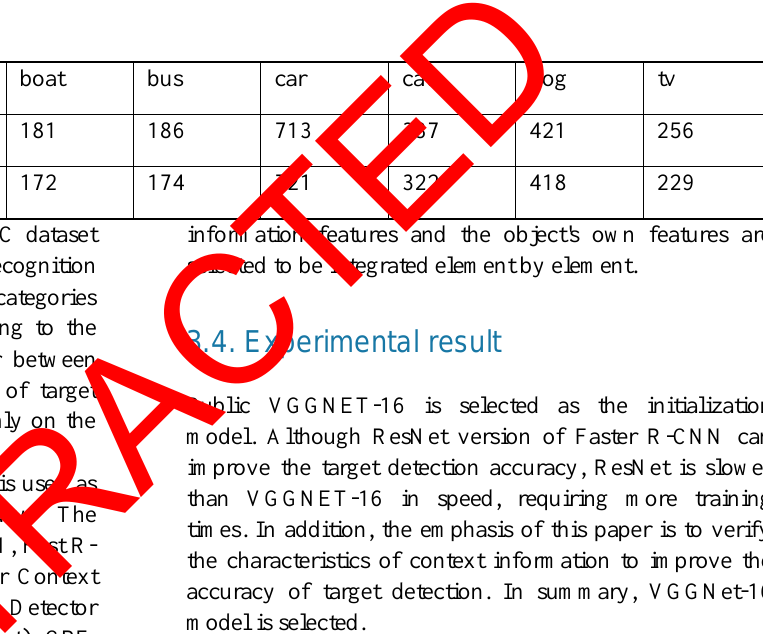
Table 1. Statistics of PASCAL VOC2007 dataset